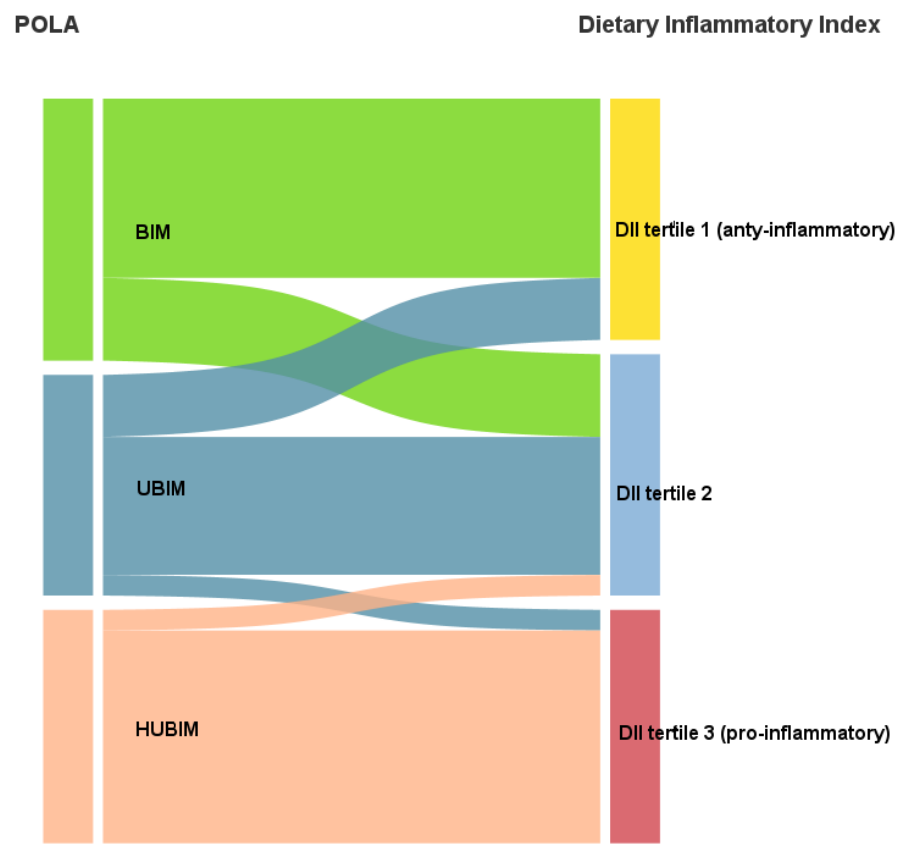
Figure 4. Sankey diagram showing agreement of the DII and POLA index (kappa =